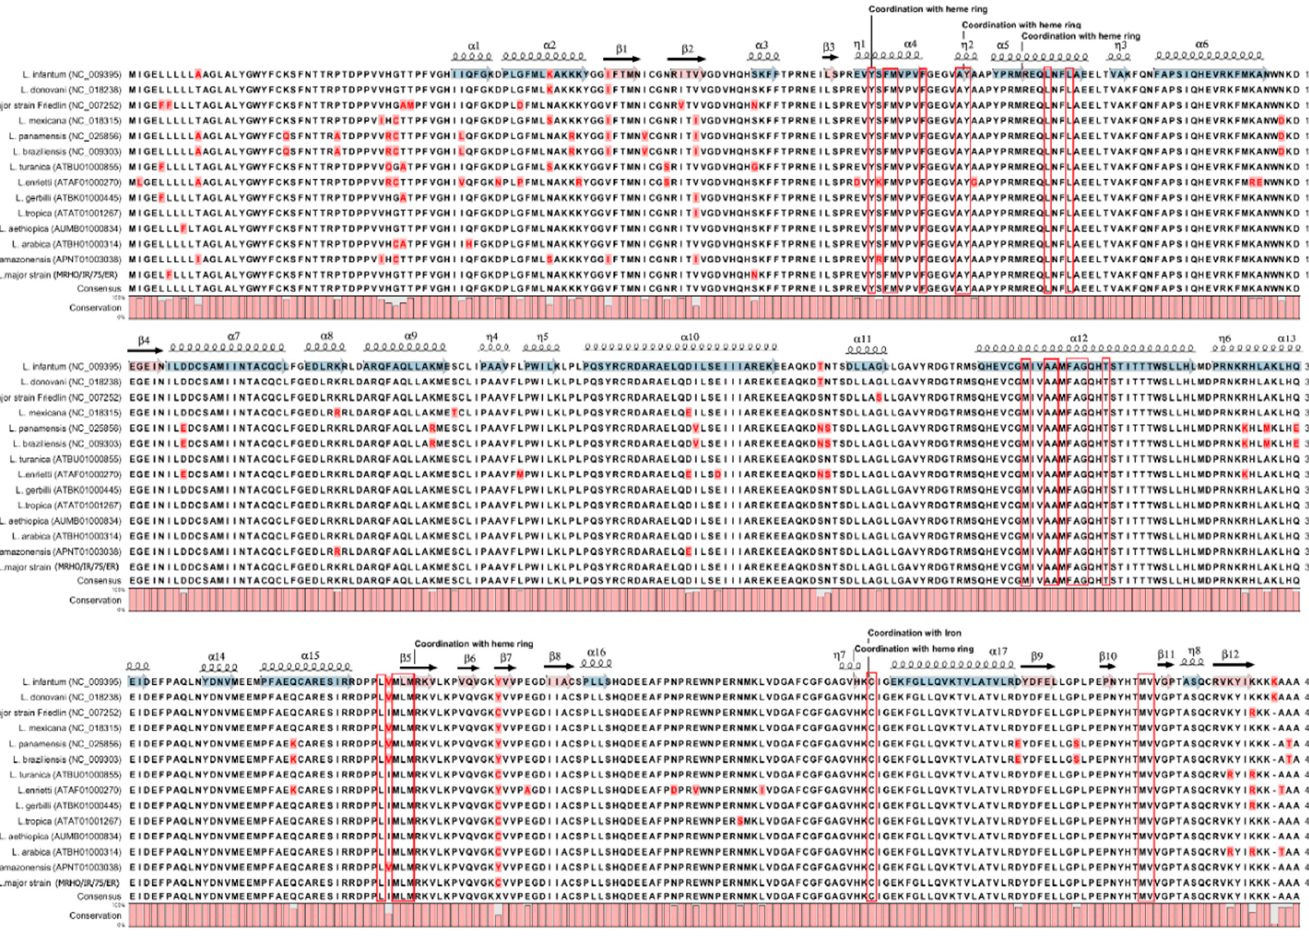
Figure 4. Multiple alignment of putative amino acid sequence of CYP51 in 14 Leishmania species. Alpha helix and beta strand were shown on the sequence. Those residues participating in the ligand binding pocket were shown with red boxes. The secondary structures were obtained from the crystal structure of CYP51 of L. infantum (PBD code 3L4D).